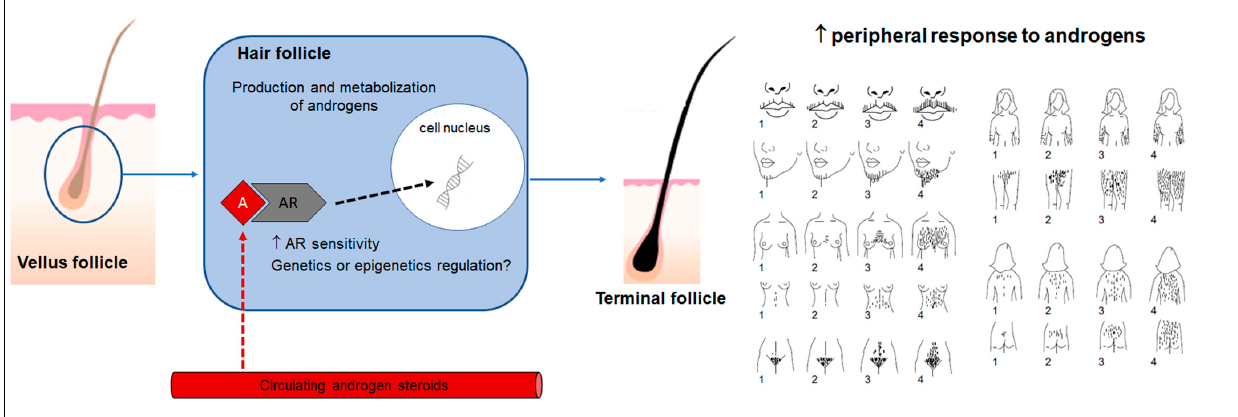
Figure 1. Role of androgens in the hair follicle and its peripheral response. A: androgens; AR: androgen receptor; ↑ peripheral response to androgens is expressed graphically by the modified Ferriman–Gallwey scale.